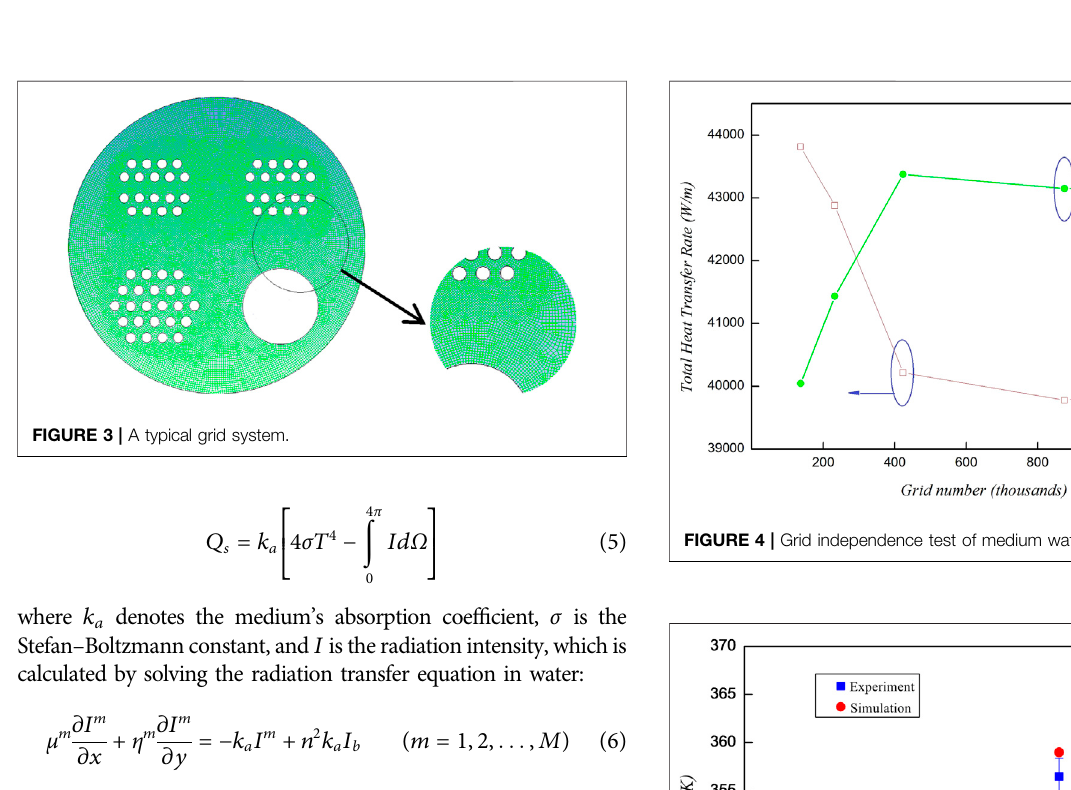
FIGURE 2 | (A) Cross-section of a gas heater simulated using a numerical model. (B) A zoom-in of the convective tube bundle.